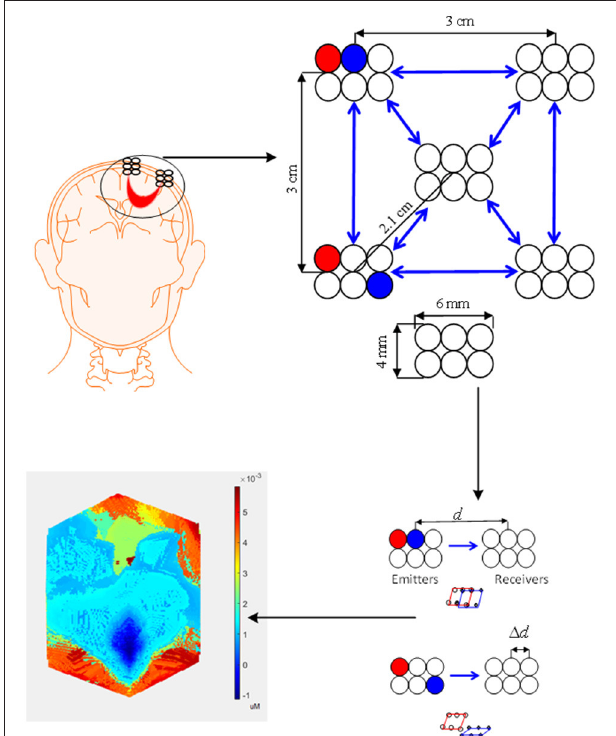
FIGURE 6 | Bundled optode scheme: A schematic of densely configured fNIRS probes for deep brain